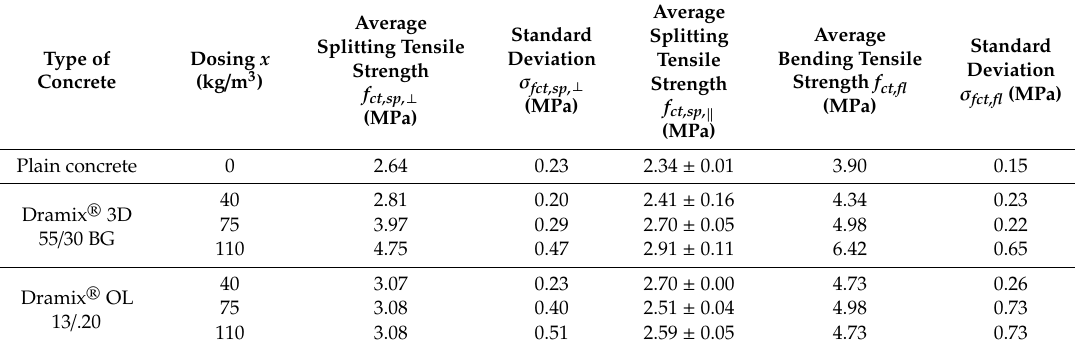
Table 3. Material properties of plain concrete and fiber-reinforced concrete: tensile